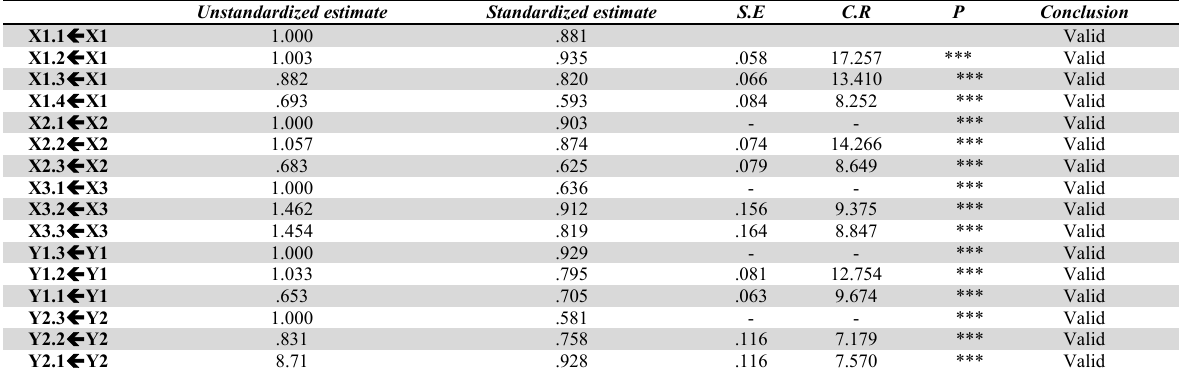
Regression Weights Unstandardized estimate Standardized